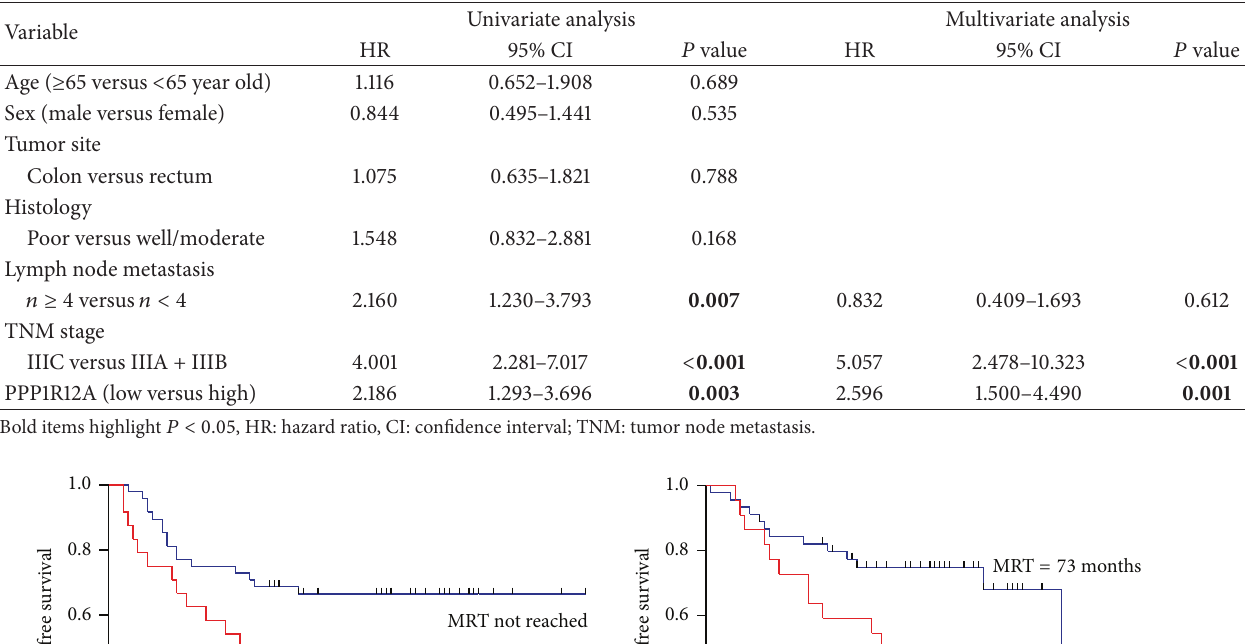
Table 2: Univariate and multivariate analyses for recurrence-free survival (Cox proportional hazard model).